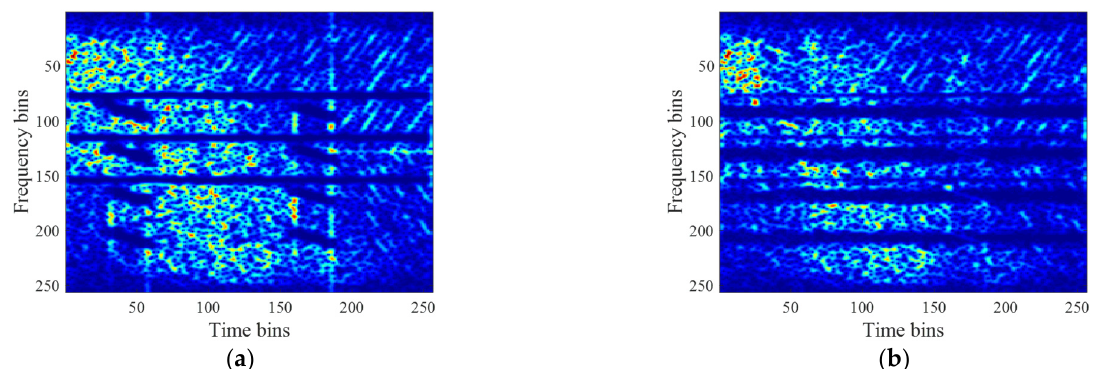
Figure 11. Spectrograms of the results after applying ( a ) ISNF and ( b ) ESP.